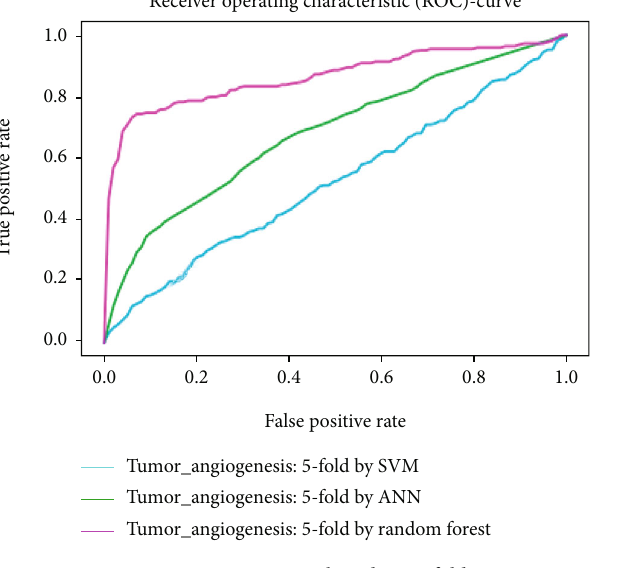
Figure 14: Comparison of jackknife testing.